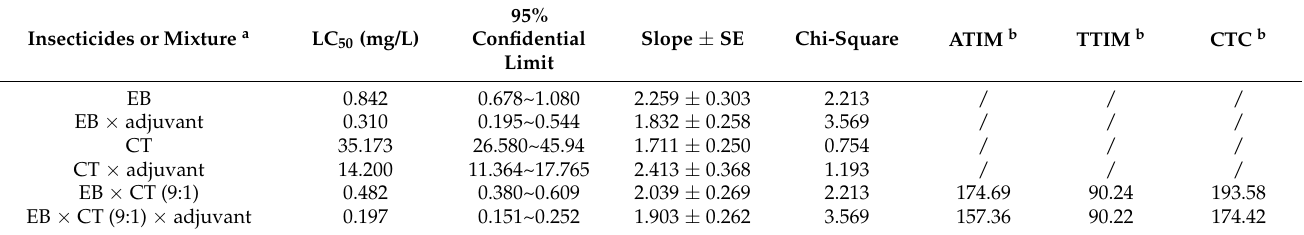
Table 2. Synergistic effect of Jijian ® adjuvant on the toxicity of emamectin benzoate, chlorantranilip- role and EB × CT in leaf-spray bioassays.